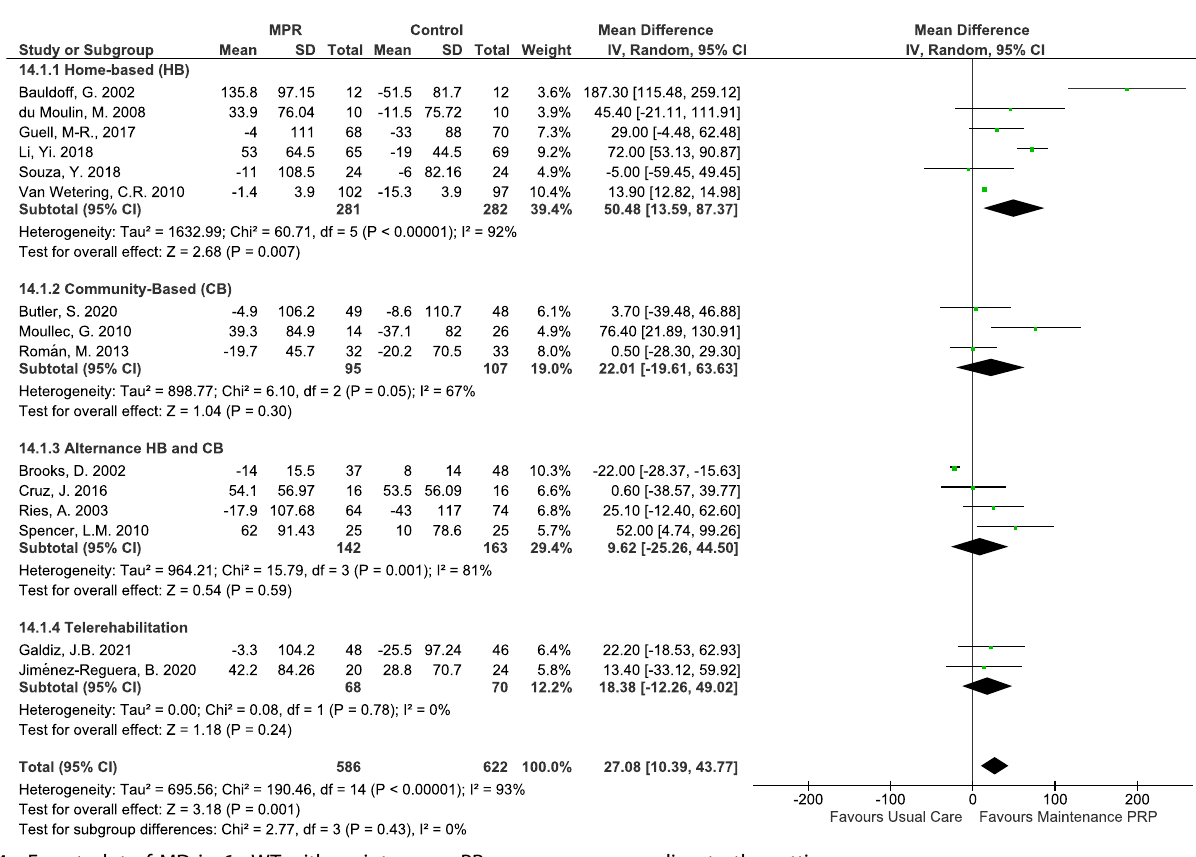
Fig. 4 Forest plot of MD in 6mWT with maintenance PR programme, according to the setting.